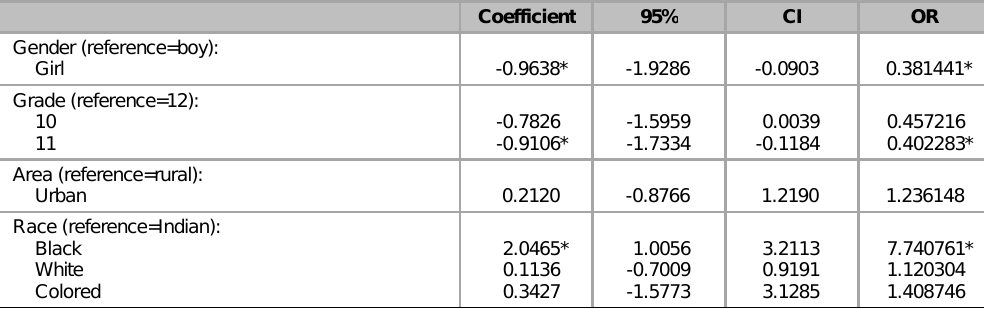
Results of the quasi logistic regression with estimates of odd ratios (OR) and 95 per cent confidence intervals